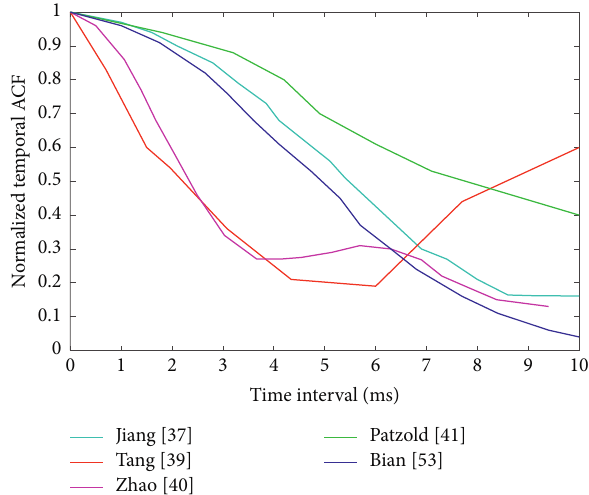
Figure 3: Comparison between the temporal ACFs that are pro- duced by 5 GBSM